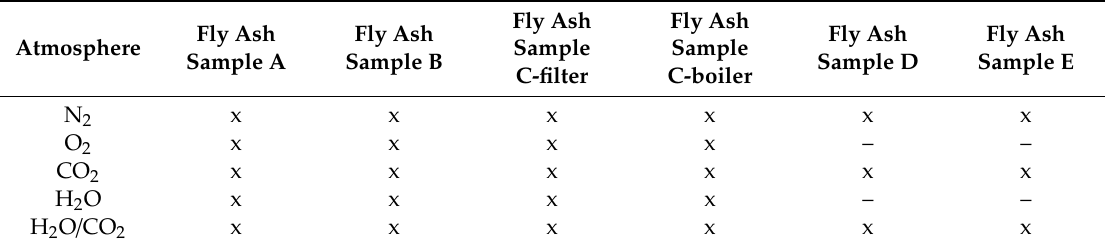
Table 1. An overview of the STA experimental runs for di ff erent fly ash samples ((x) for performed and (–) for not